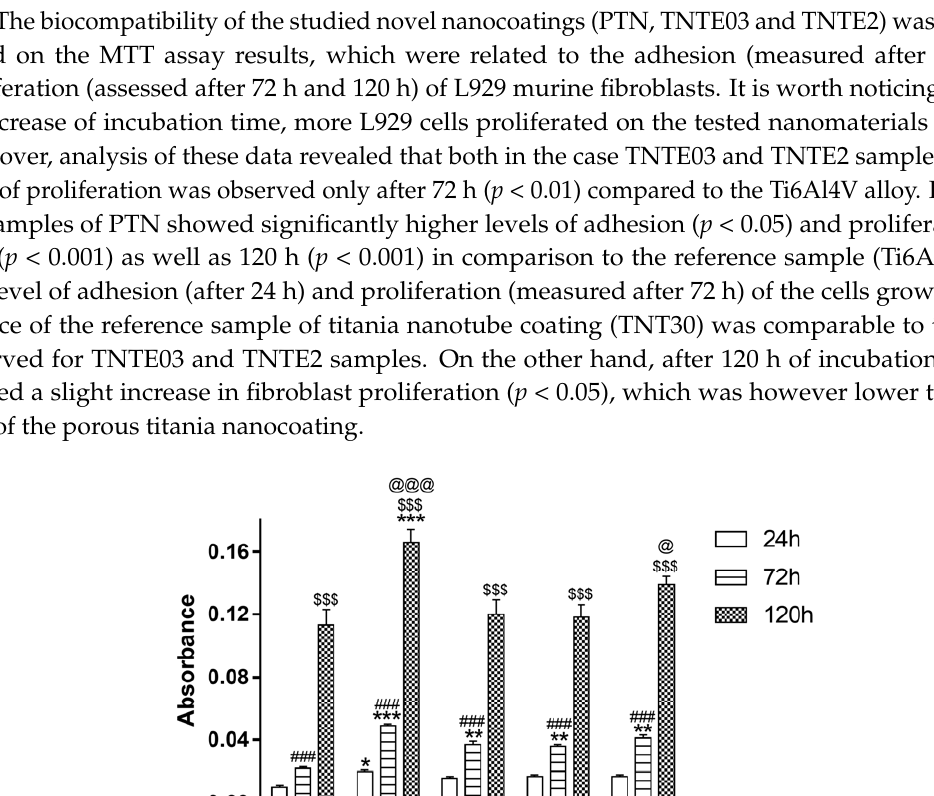
Table 1. The k obs rate constants for MB photodegradation of blind test (without UV light and samples), and tests with porous coatings produced in glycol-based electrolyte containing HF and 0.3 wt % (TNTE03), 1 wt % (PTN), and 2 wt % (TNTE2) water. Obtained results are compared to k obs rate constant for methylene blue photodegradation of the reference sample of titania nanotubes coating (TNT30) produced using constant potential 30 V.